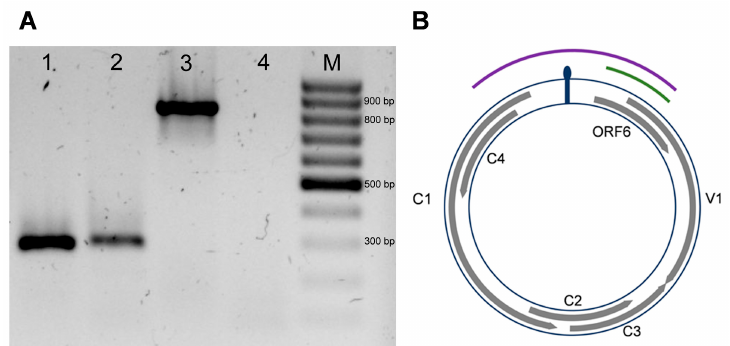
Figure 5. Genetic analysis of ORF 6 from ToTLV. (A) PCR and RT-PCR products from ToTLV-infected tomato plants. PCR and RT-PCR assays, respectively, using primers Be-089F/Be-363R (1 and 2). PCR and RT-PCR assays, respectively, using primers Be-2147F/Be-363R (3 and 4). (B) Schematic representation of ToTLV showing the typical five genes of the DNA-A components of New World begomoviruses (capsid protein gene (V1), replication-associated protein gene (C1), transcriptional activator protein gene (C2), replication enhancer protein gene (C3), and the C4 protein gene (C4)) and the additional ORF 6, which encompasses the intergenic region (IR) and the 5 ′ end of the V1 gene. The green line represents the expected amplification product with primer pair Be-089F/Be-363R. The purple line represents the expected amplification product with primer pair Be-2147F/Be-363R.